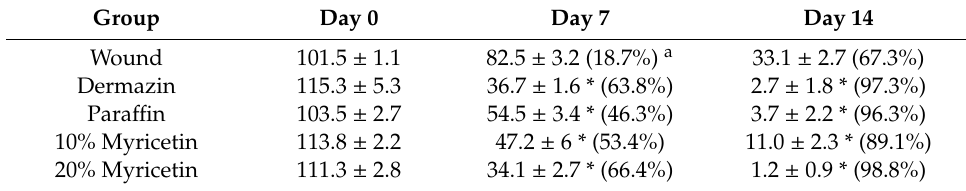
Table 1. The change of wound area (mm 2 ) and contraction percentage (%) in each group.